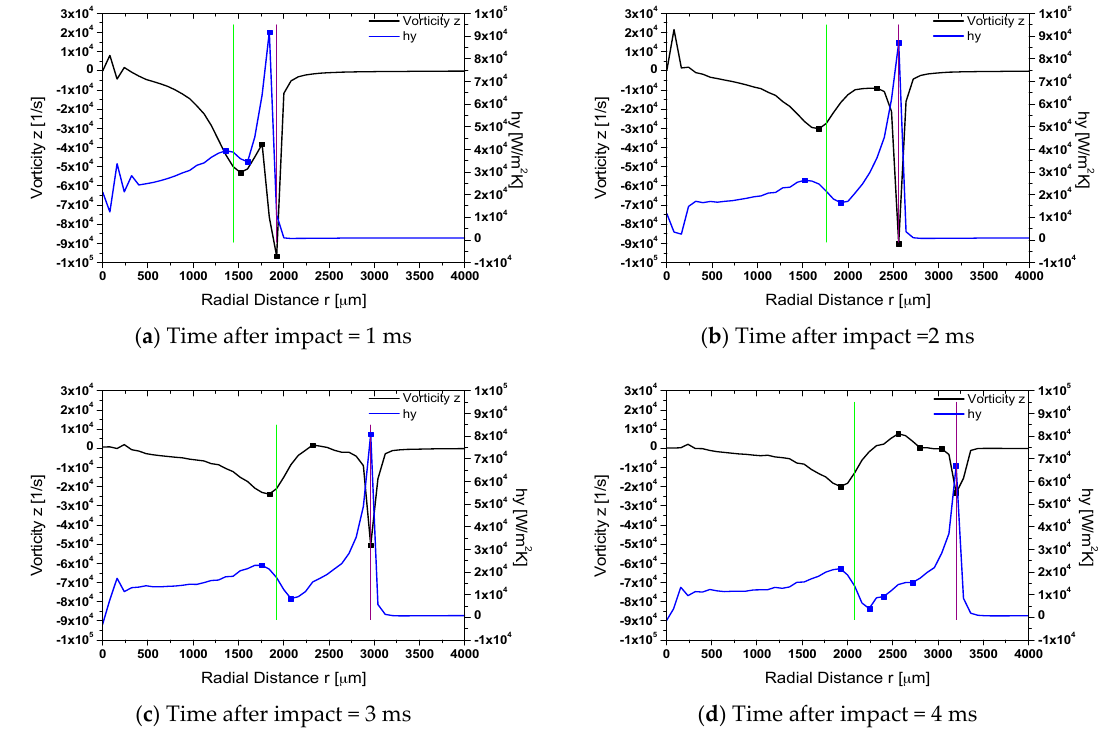
Figure 12. Vorticity in the Z direction and heat transfer coefficient numerically evaluated along the droplet radial distance, at different times after impact, for We = 24 and Tw (in) = 353.15 K. In the plots, the squares in the curves highlight the local maxima and minima of the numerically evaluated vorticity and heat transfer coefficients. The green line identifies the rim entrance and the purple line identifies the contact line.